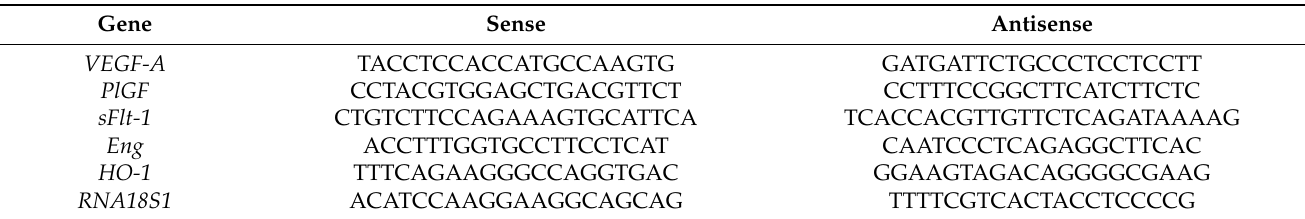
Table 1. Primer sequences for target